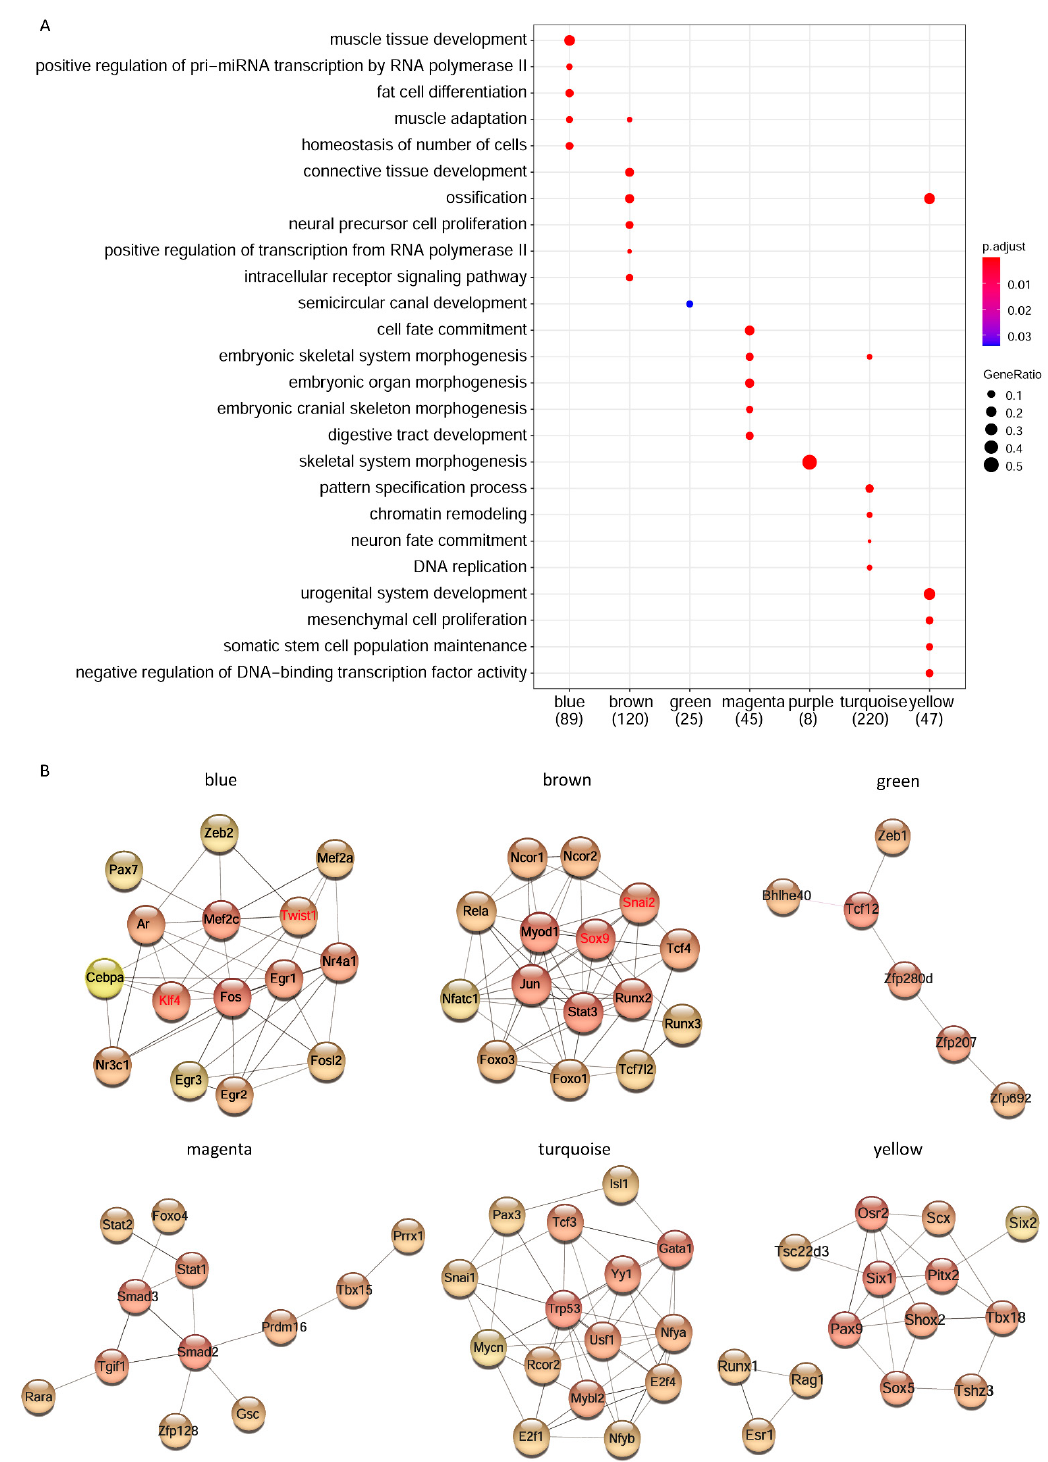
Figure 4. Construction of the transcription factor network during mouse hindlimb